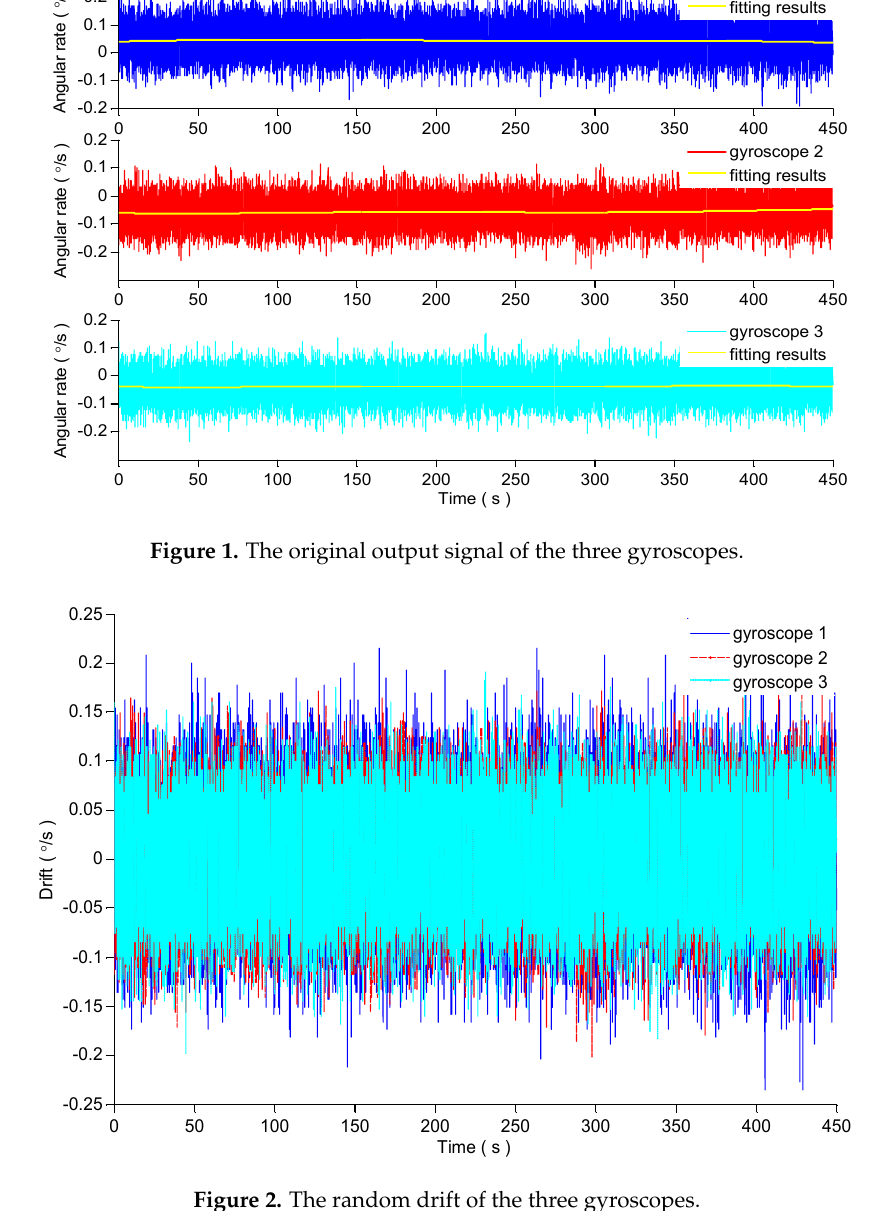
Figure 2. The random drift of the three gyroscopes.